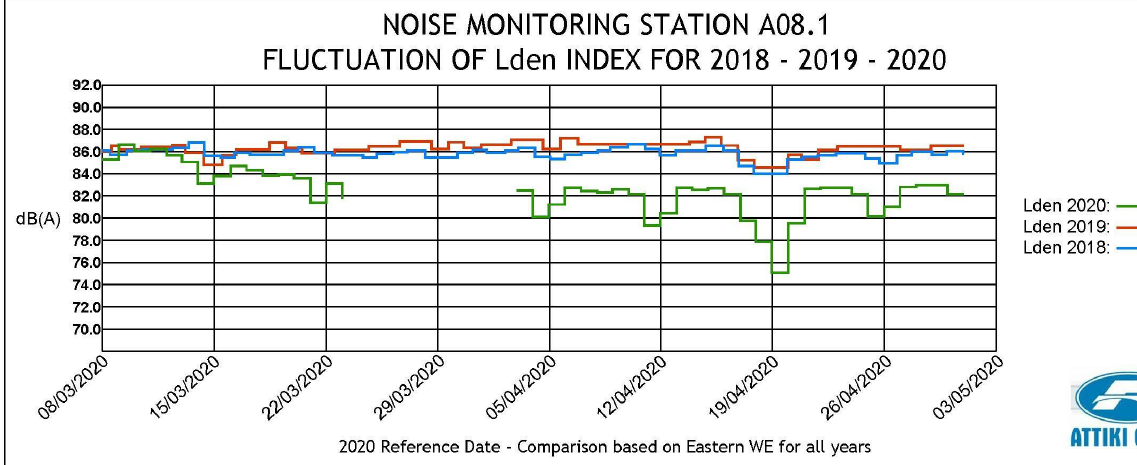
Figure 9a: Fluctuation of L den index – Noise monitoring station A06